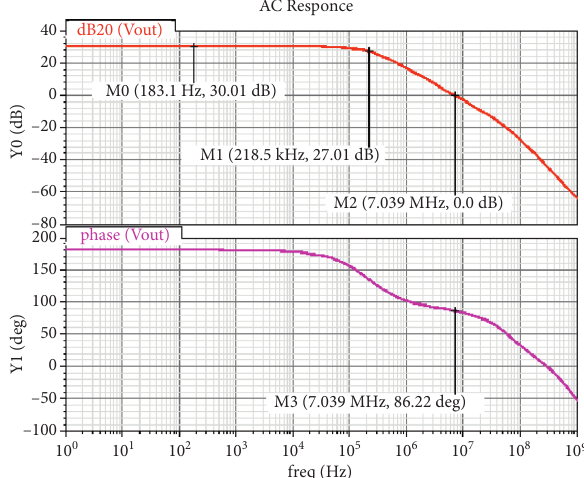
Figure 5: The designed analog multiplier.